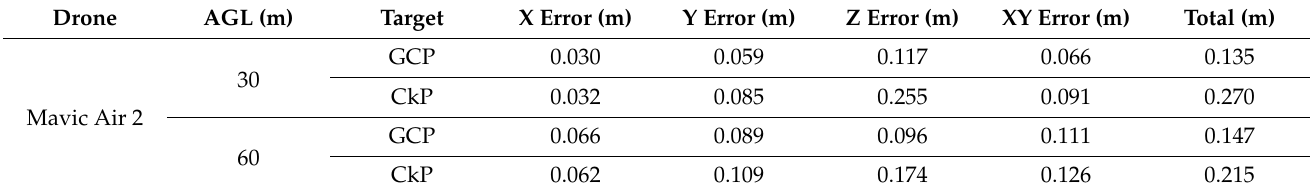
Table 5. Residuals on GCP and CkP for the survey made by the Mavic Air 2 Adv at different AGLs. Total represents the total error of the 3 components.